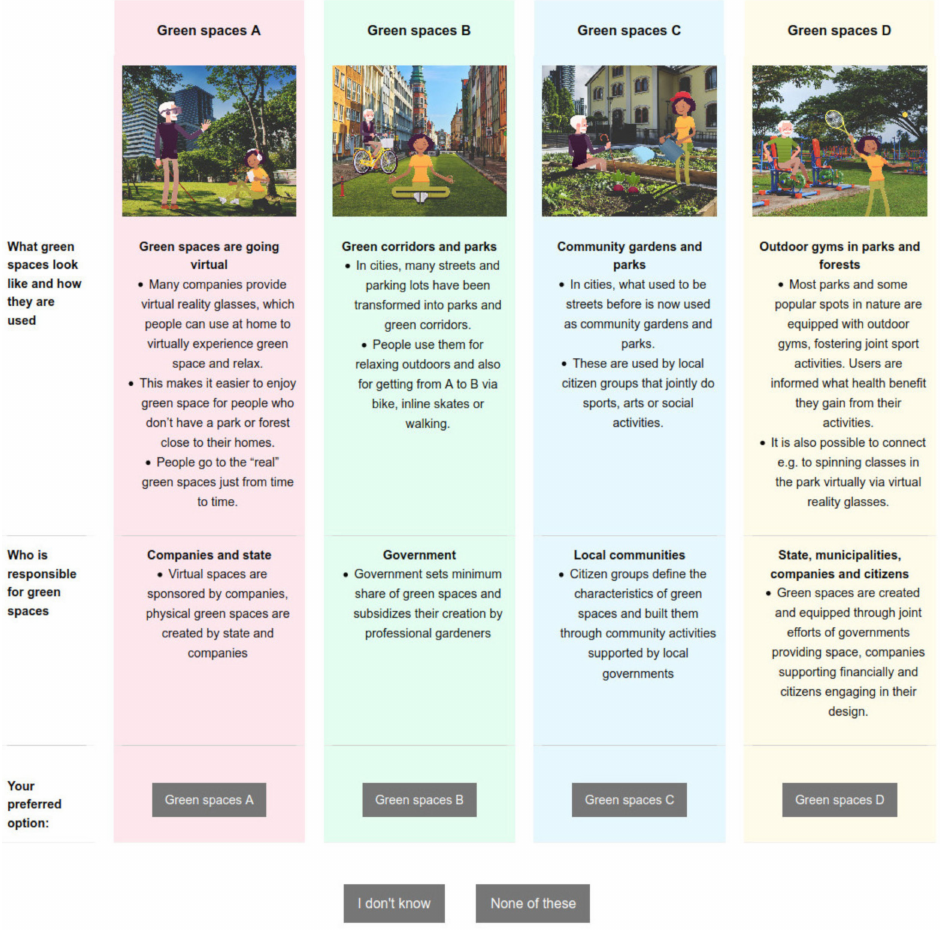
Figure A3. Example of a choice card—INHERIT scenarios, green spaces domain (Green space A corresponds to the “My life between realities” scenario, Green space B to the “Less is more to me” scenario, Green space C to the “One for all, all for one” scenario, and Green space D to the “Our circular community”